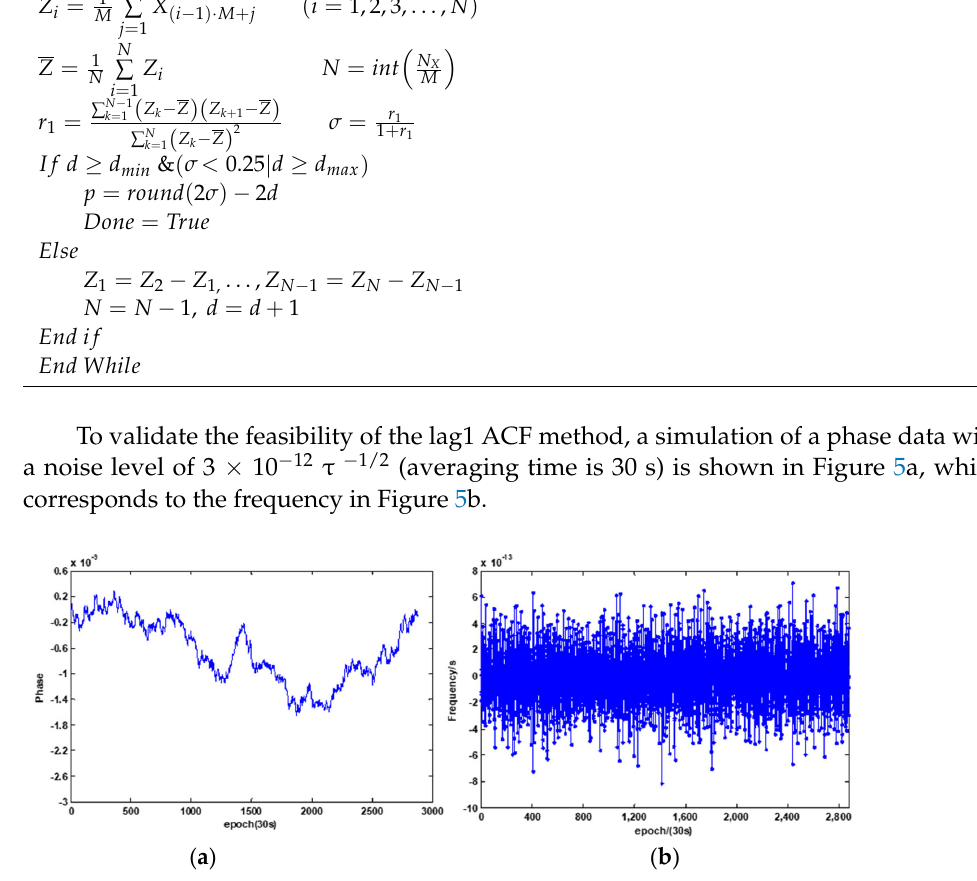
Figure 5. ( a ) Simulated phase and ( b ) frequency series.